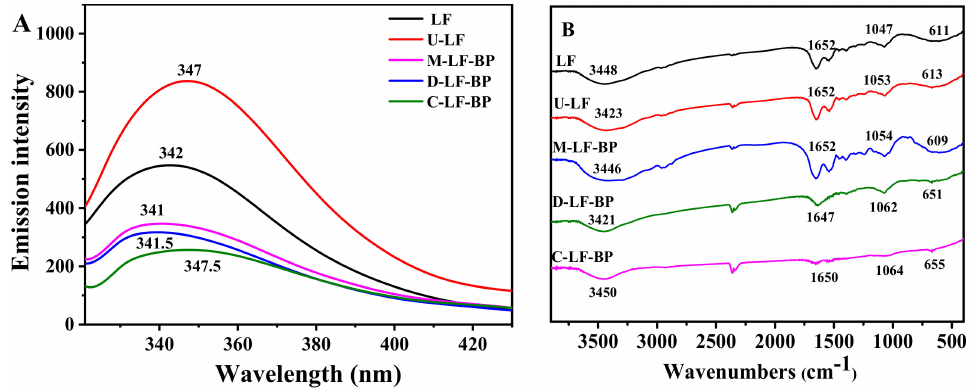
Figure 3. ( A ) Fluorescence intensity and ( B ) FTIR spectra of LF, U-LF, M-LF-BP, D-LF-BP and